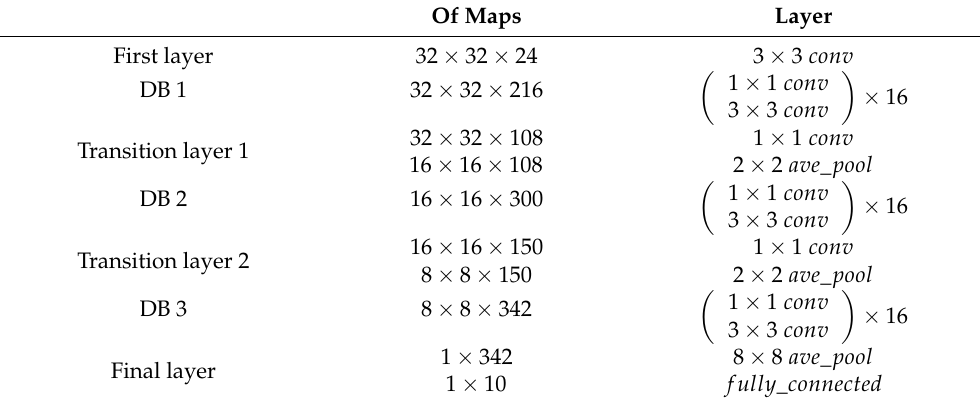
Table 2. Details of DenseNet-100.